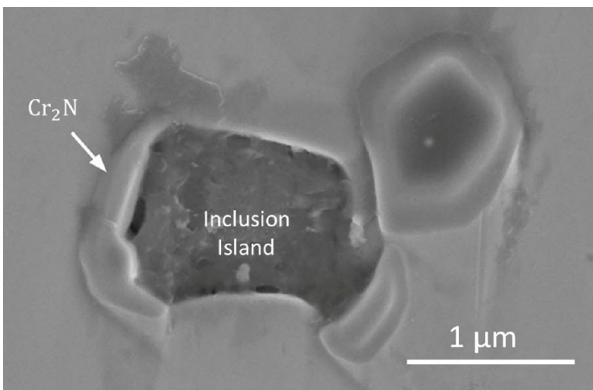
Figure 13. Cr 2 N precipitations around the inclusion island after heat treated at 1100 °C for 30 min (adapted from [73]).